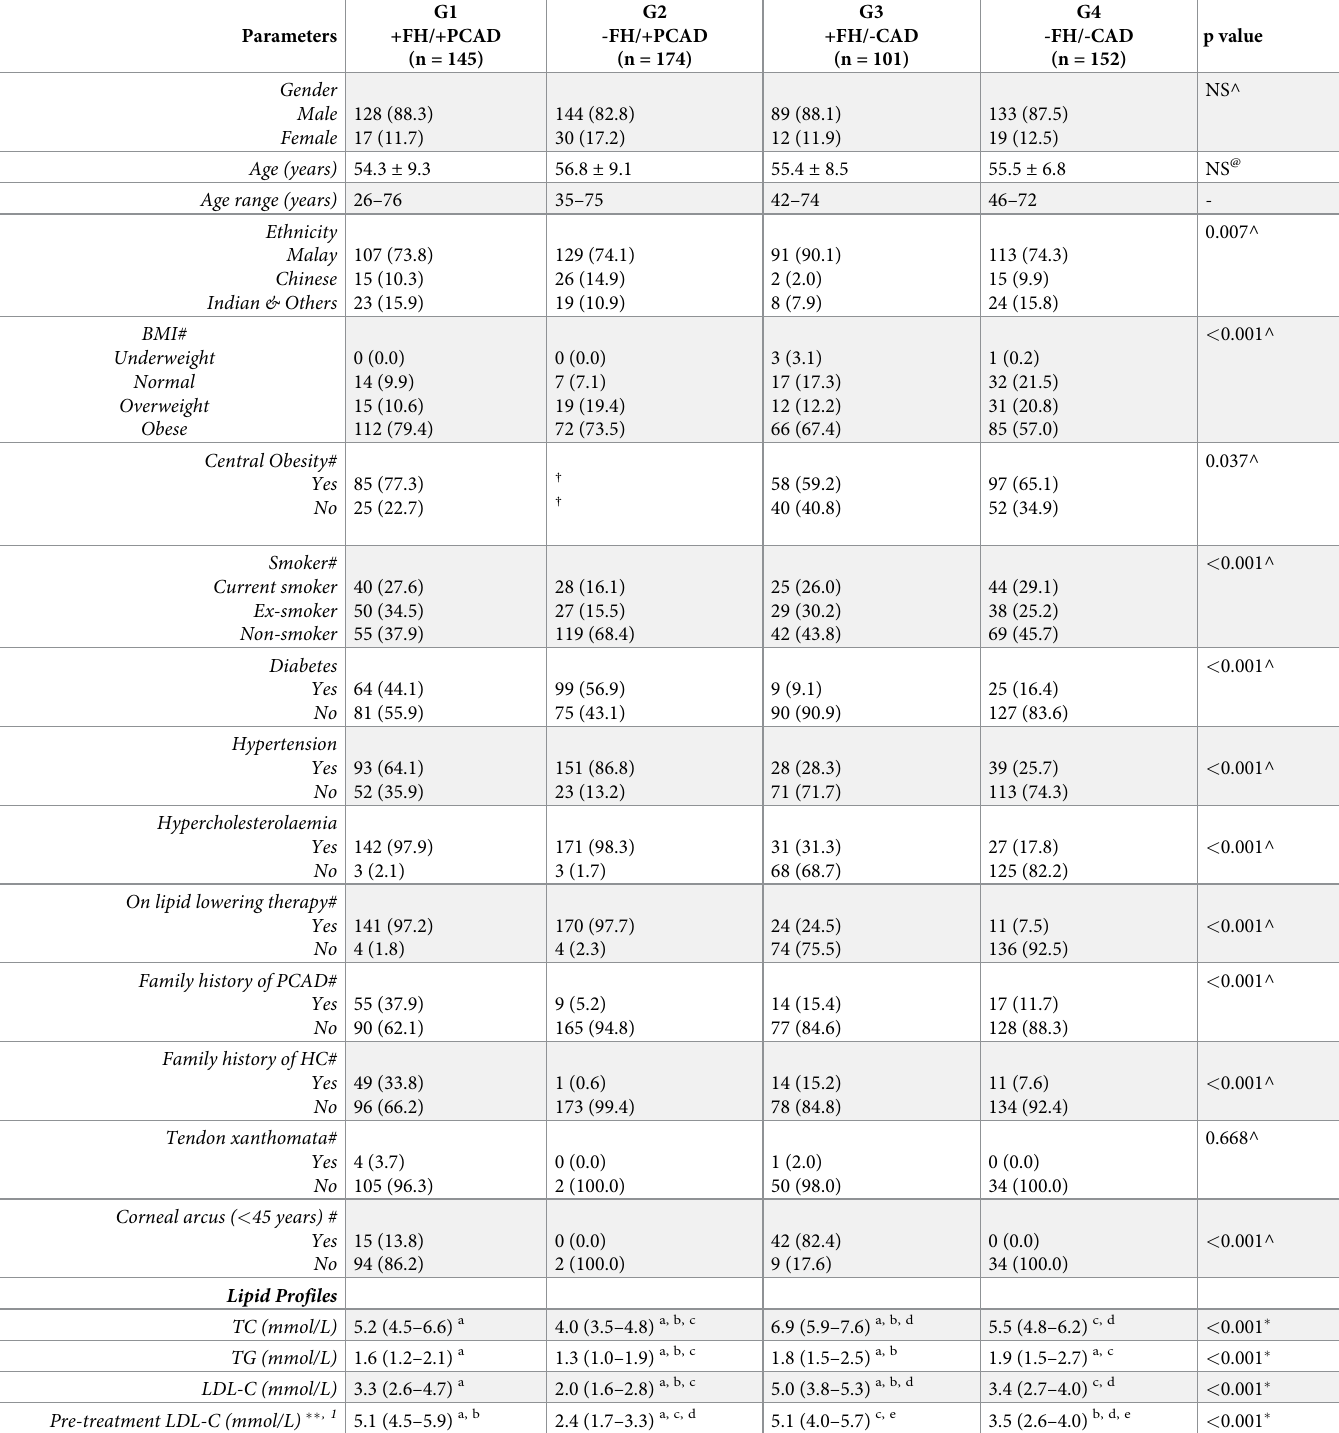
Table 1. Distribution of individuals based on the presence of CAD and clinical diagnosis of FH (n =